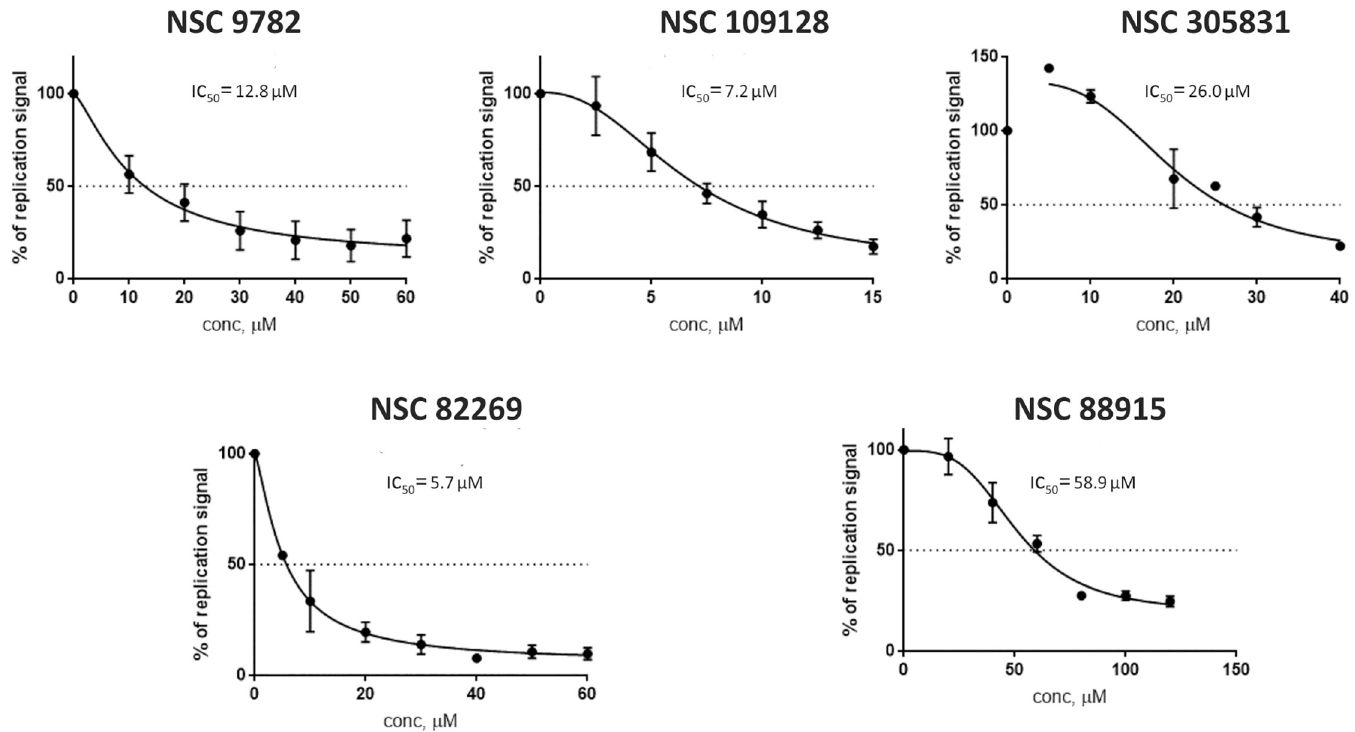
Fig 4. The inhibition of initial amplification of the MfPV8 genomes by the high-risk HPV-specific compounds. U2OS cells were transfected with 4 μ g of the MfPV8 minicircle genomes and grown with the compounds for 5 days at the indicated concentrations. Genomic DNA was extracted, MfPV8 DNA was linearized and treated with DpnI, and analyzed by Southern blotting. The DNA replication signals of the MfPV8 were quantified (ImageQuant TL 8.1, GE Healthcare), expressed relative to the vehicle control (DMSO), and the inhibition curves and IC50 values for each compound were calculated by curve fitting ([inhibitor] vs. concentration, variable slope, 4 parameters). Error bars represent the standard deviation from 2–3 independent